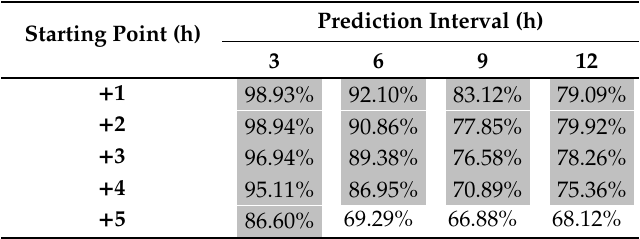
Table 5. Forecast accuracy percentages for the flood event in 2006. This table shows the grid percentage to the total wet grids with average RMSE within 0.3 m. The forecast begins by the starting point, several hours later than the event beginning for the real-time forecast.